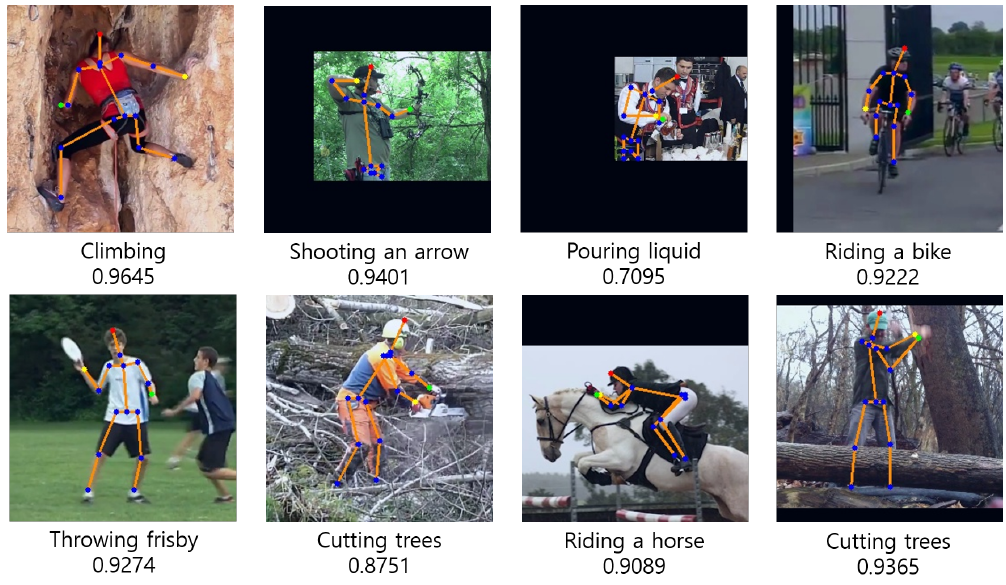
Figure 8. Pose estimation and action recognition results on the MPII Human Pose Dataset [17]. Predicted action classes along with confidence scores are shown below the individual results.